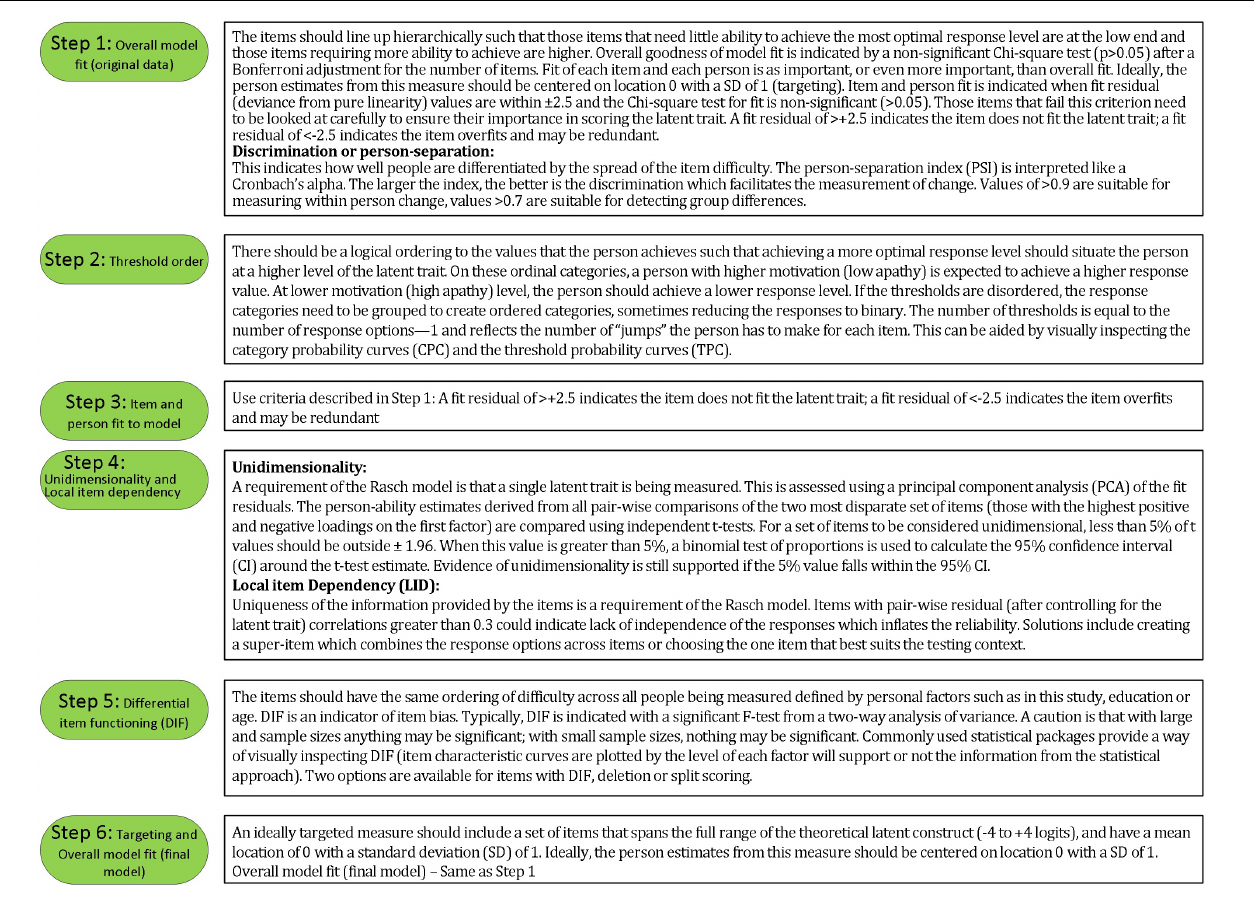
FIGURE 3 | Explanation of steps taken to fit the data to the Rasch